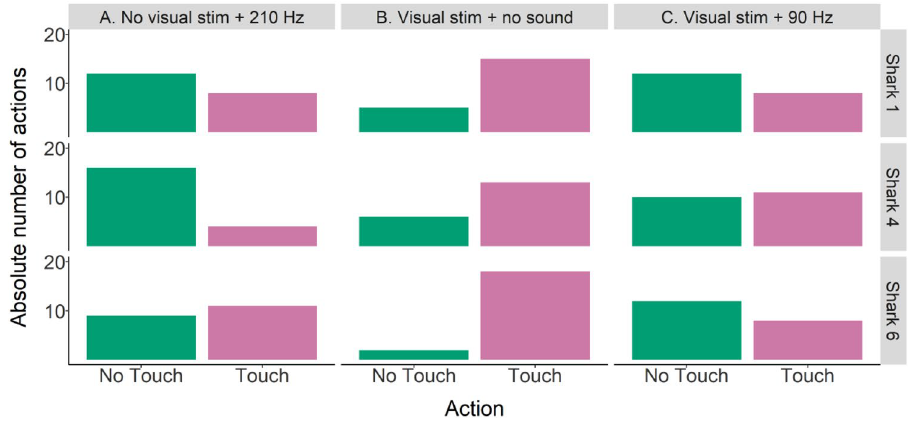
Figure 8. Individual data for absolute number of action (not touching or touching the loudspeaker) per transfer type (A, B or C).